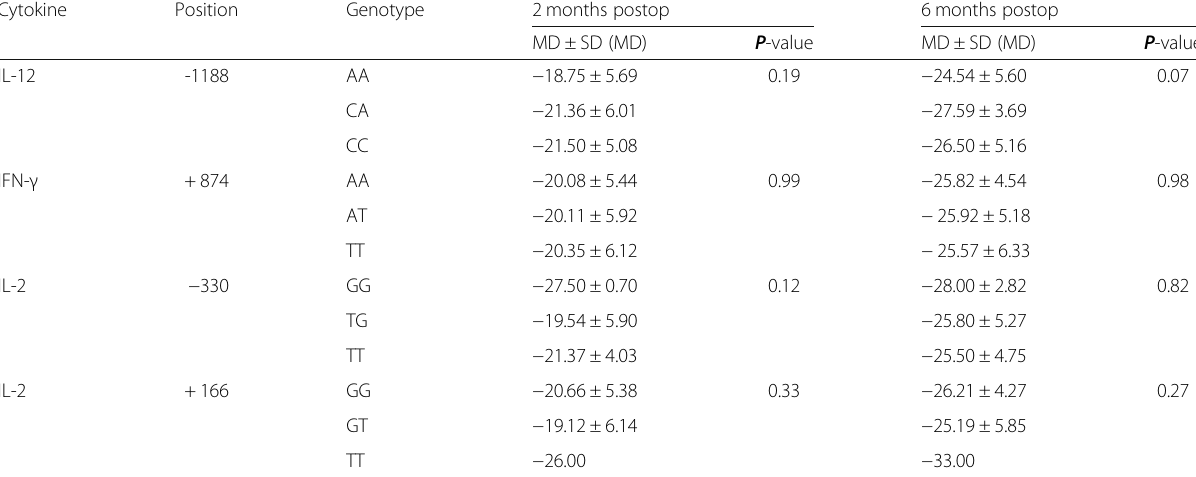
Table 3 Association between cytokine genotypes and 2 months or 6 months postop OSW changes in IVDD patients Cytokine